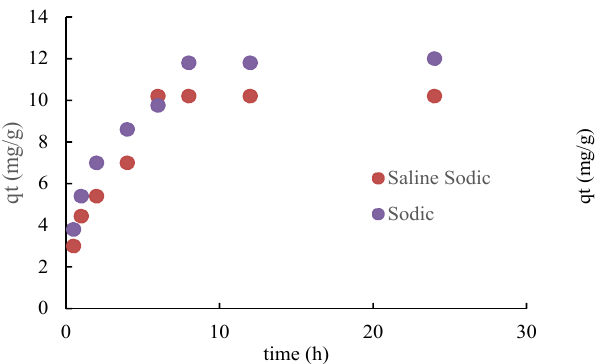
Fig. 2: COD values of soil column leachate and removal percentage over 10 pore volumes of leaching experiment